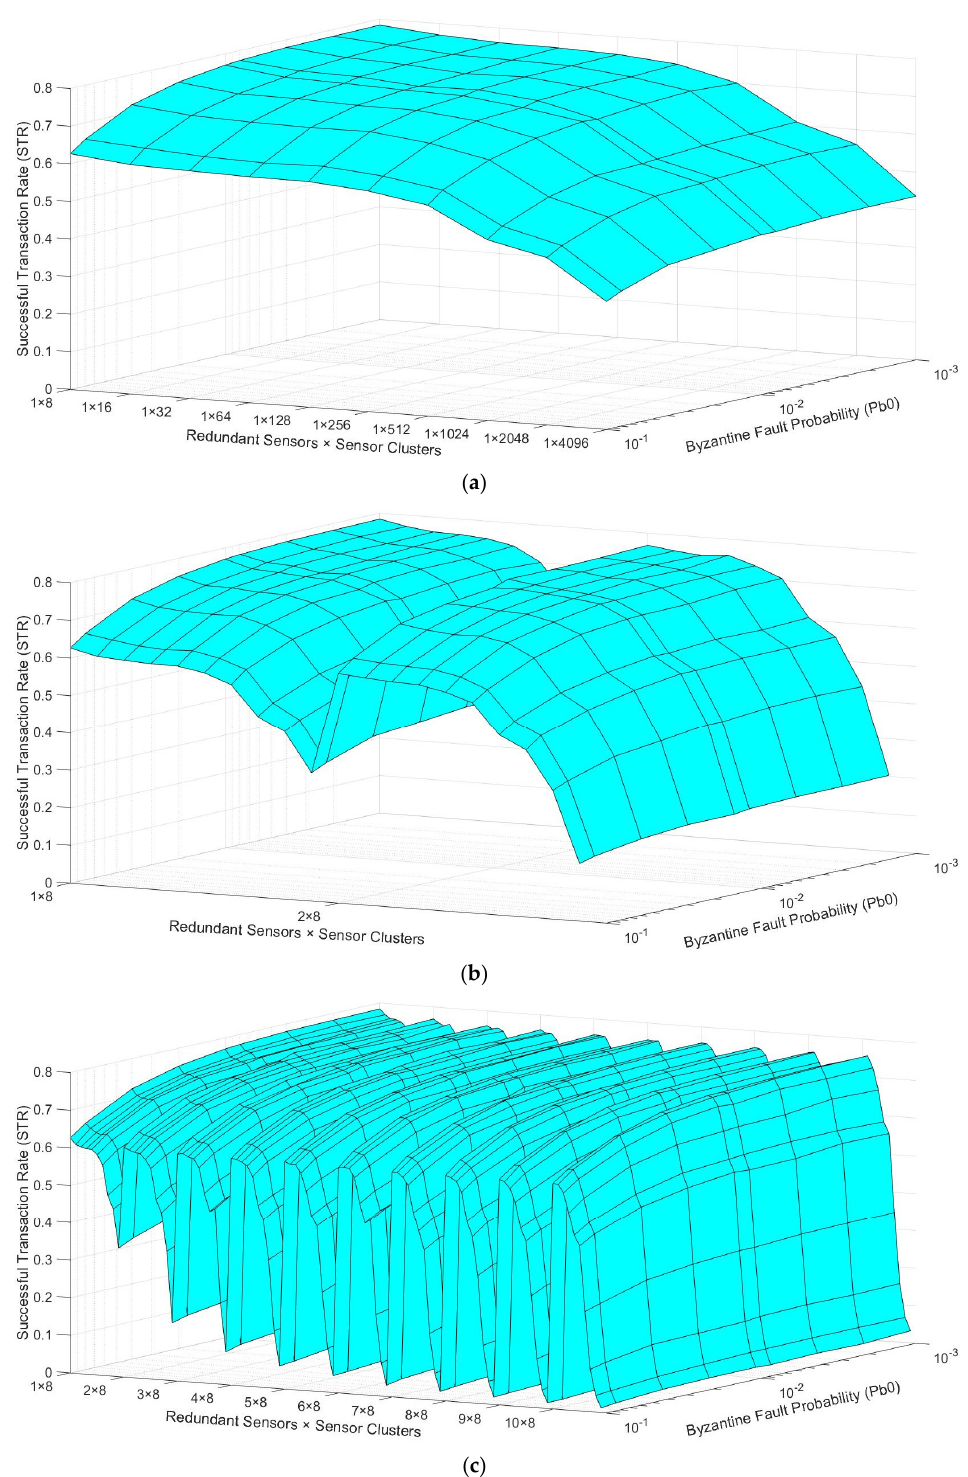
Figure 7. Trustworthiness mesh examples: ( a ) only one redundant sensor per cluster; ( b ) one or two redundant sensors per cluster; ( c ) one to ten redundant sensors per cluster.